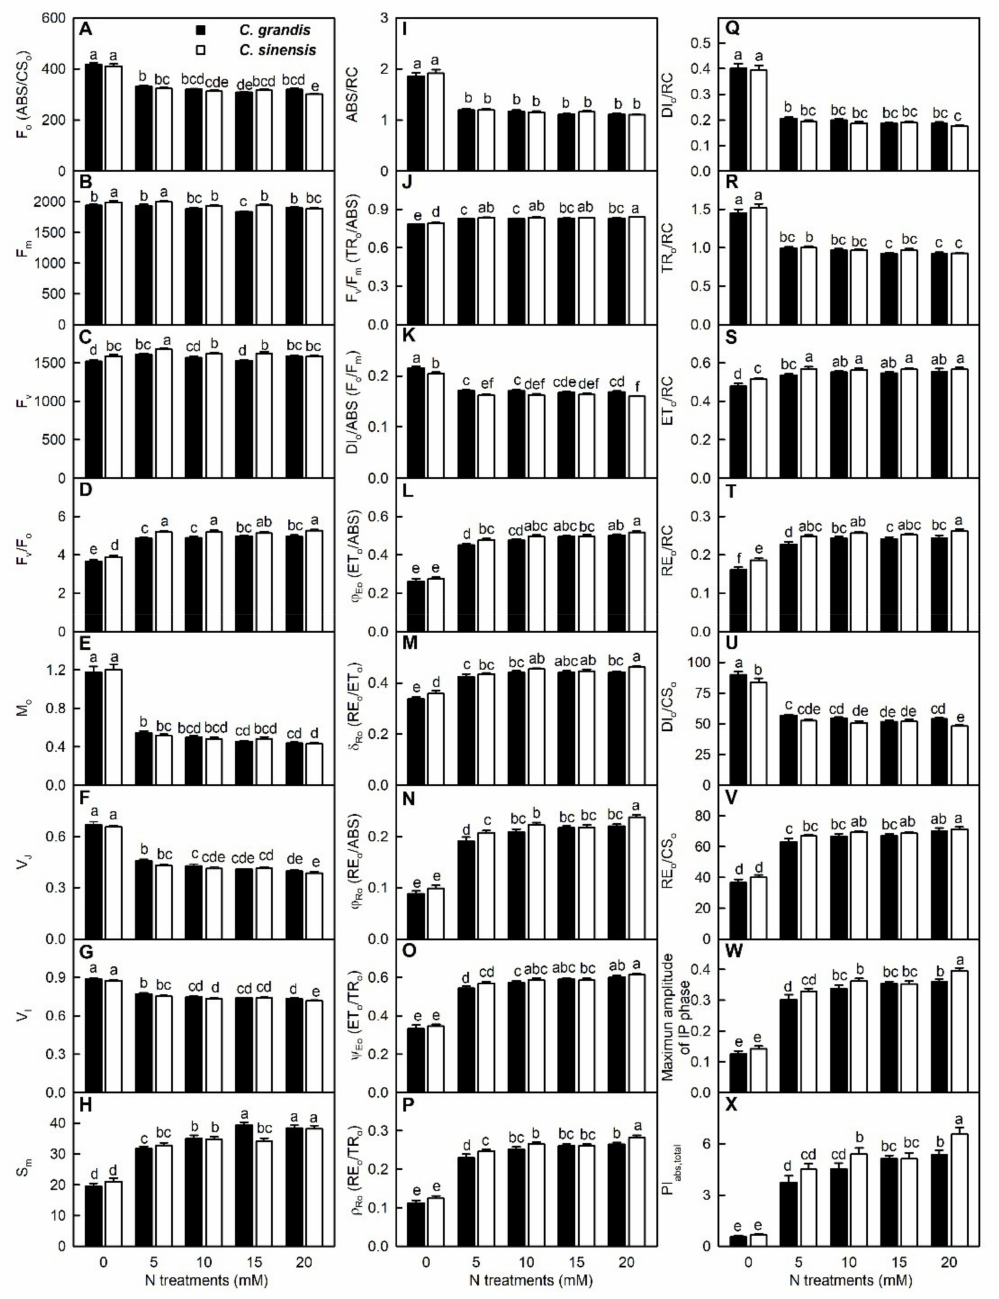
Figure 9. Effects of N supply on mean ( ± SE, n = 10) F o (ABS/CS o , ( A )), F m ( B ), F v ( C ), F v /F o ( D ), M o ( E ), V J ( F ), V I ( G ), S m (EC o /RC, ( H )), ABS/RC ( I ), F v /F m (TR o /ABS, ( J )), DI o /ABS (F o /F m , ( K )), ϕ Eo (ET o /ABS, ( L )), δ Ro (RE o /ET o , ( M )), ϕ Ro (RE o /ABS, ( N )), ψ Eo (ET o /TR o , ( O )), ρ Ro (RE o /TR o , ( P )), DI o /RC ( Q ), TR o /RC ( R ), ET o /RC ( S ), RE o /RC ( T ), DI o /CS o ( U ), RE o /CS o ( V ), maximum amplitude of IP phase ( W ), and PI abs,total ( X ) in dark-adapted C. grandis and C. sinensis